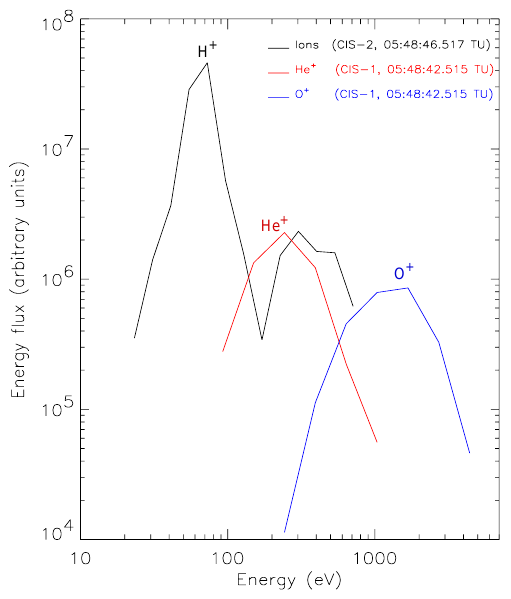
Fig. 4. Ion energy spectra from CIS-2 (averaged on board over 12s) and energy spectra for He + and O + from the mass spectrometer CIS-1 (averaged on board over 32s). Data are taken in a low energy structure encountered inside the magnetosphere, after the satellite exits from the magnetosheath at ∼ 05:48:20UT (see Fig. 3).